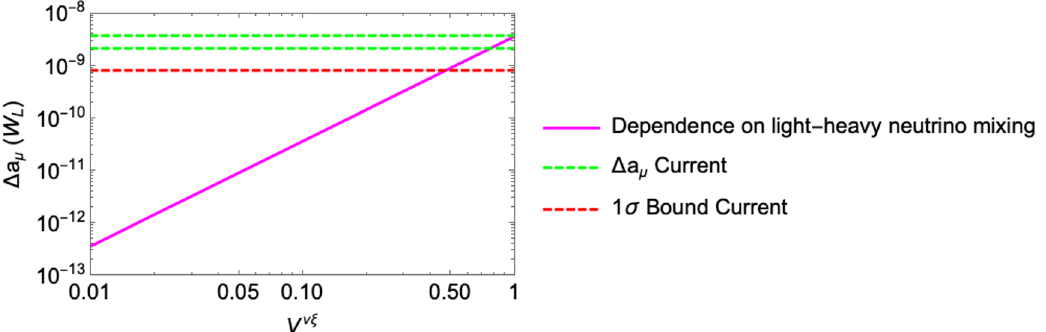
Figure 14 . Plot showing the variation of (cid:1) a (cid:22) coming from purely left-handed currents via W L mediation vs. the light-heavy mixing parameter V (cid:23)(cid:24)